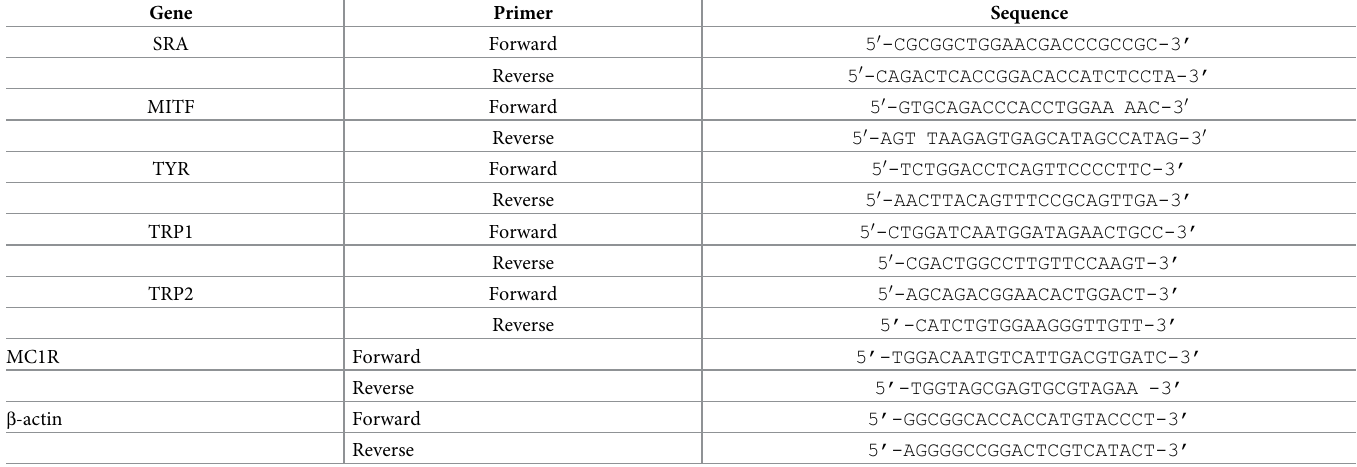
Table 1. The primers for the SRA, MITF, TYR, TRP1, TRP2, MC1R, and β -actin.